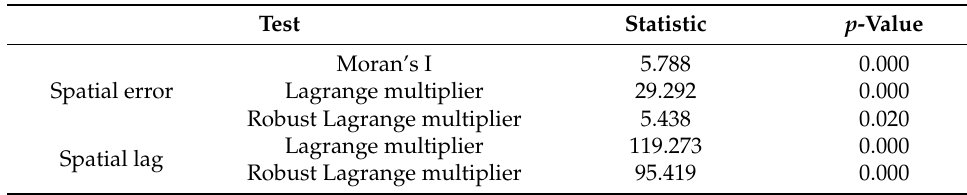
Table 6. Spatial spillover effect test and model selection.